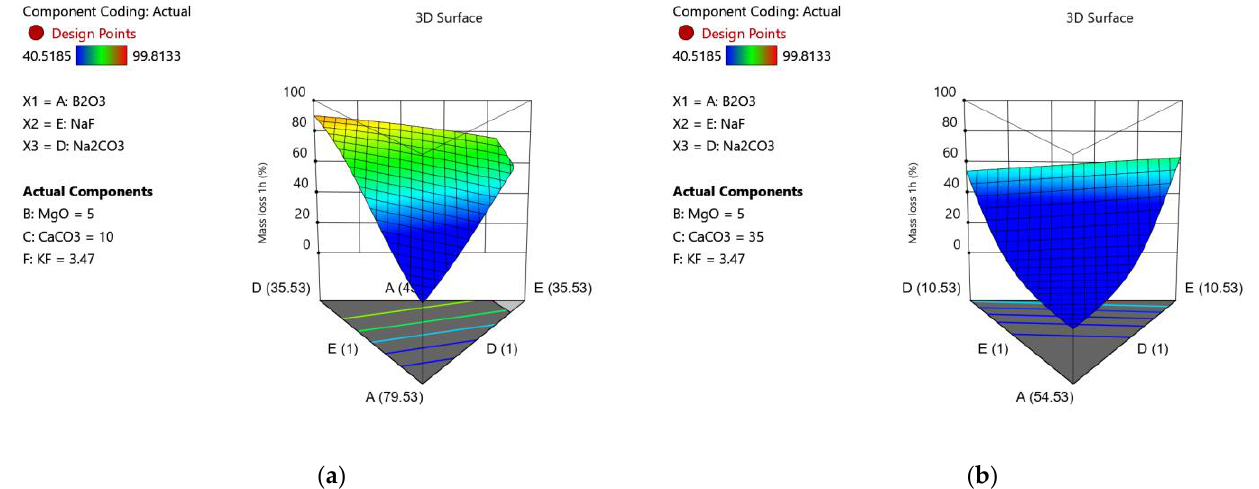
Figure 6. Visualization of the effects of Na 2 O and NF inclusion on mass loss at 1 h at ( a ) low and ( b ) high CaO loadings.